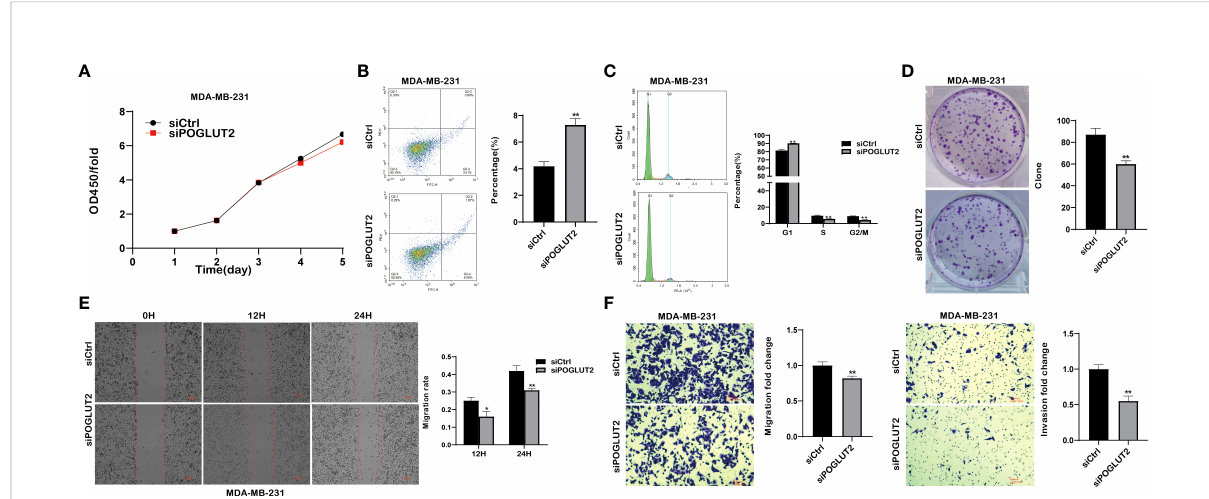
FIGURE 10 POGLUT2 regulates cell proliferation, apoptosis, cell cycle, clone formation, migration, and invasion in breast cancer cell line MDA-MB-231 in vitro . (A) Decreased cell proliferation was found in POGLUT2 knockdown MDA-MB-231. (B) Increased cell apoptosis was found in POGLUT2 knockdown MDA-MB-231. (C) Increased G1 phase and decreased S and G2 phase in POGLUT2 knockdown MDA-MB-231. (D) Decreased cell clone formation in POGLUT2 knockdown MDA-MB-231. (E) Decreased cell migration of POGLUT2 knockdown MDA-MB-231 in 2-D wound healing assay. (F) Decreased cell migration and invasion of MDA-MB-231 in 3-D transwell assay. * p < 0.05; ** p <